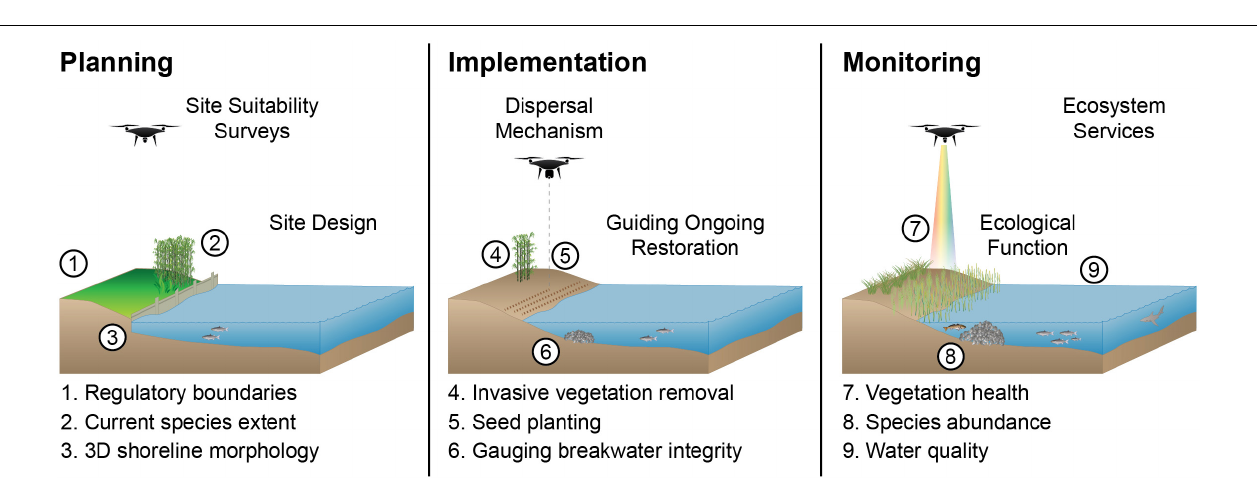
FIGURE 2 | Stitched orthomosaic of a living shoreline (saltmarsh and oyster reef) situated on Pivers Island, North Carolina (A) . Densified point cloud of the site with ground control points designated by green arrows (B) . Digital elevation model of the site with water artifacts along the bottom edge (C) . Normalized difference vegetation index of the site obtained from concurrent multispectral UAS imagery (D) .